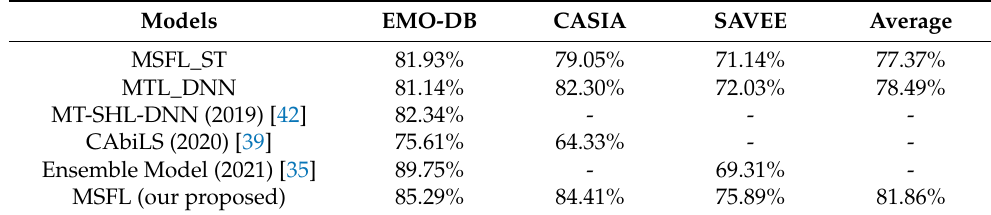
Table 6. Accuracy of different models for SER on discrete